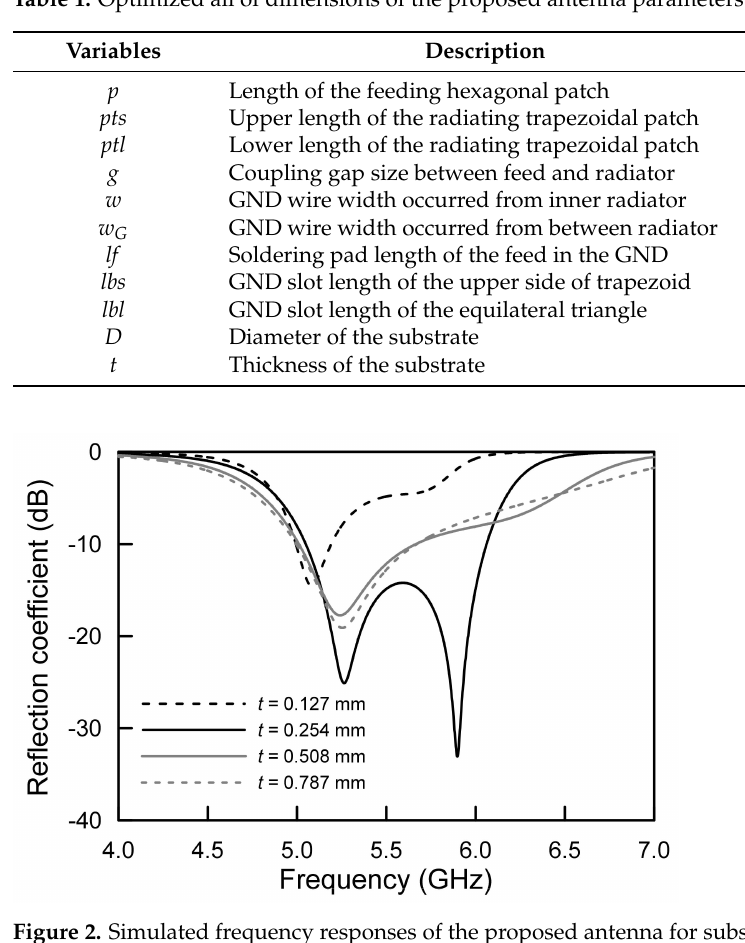
Figure 2. Simulated frequency responses of the proposed antenna for substrate thickness